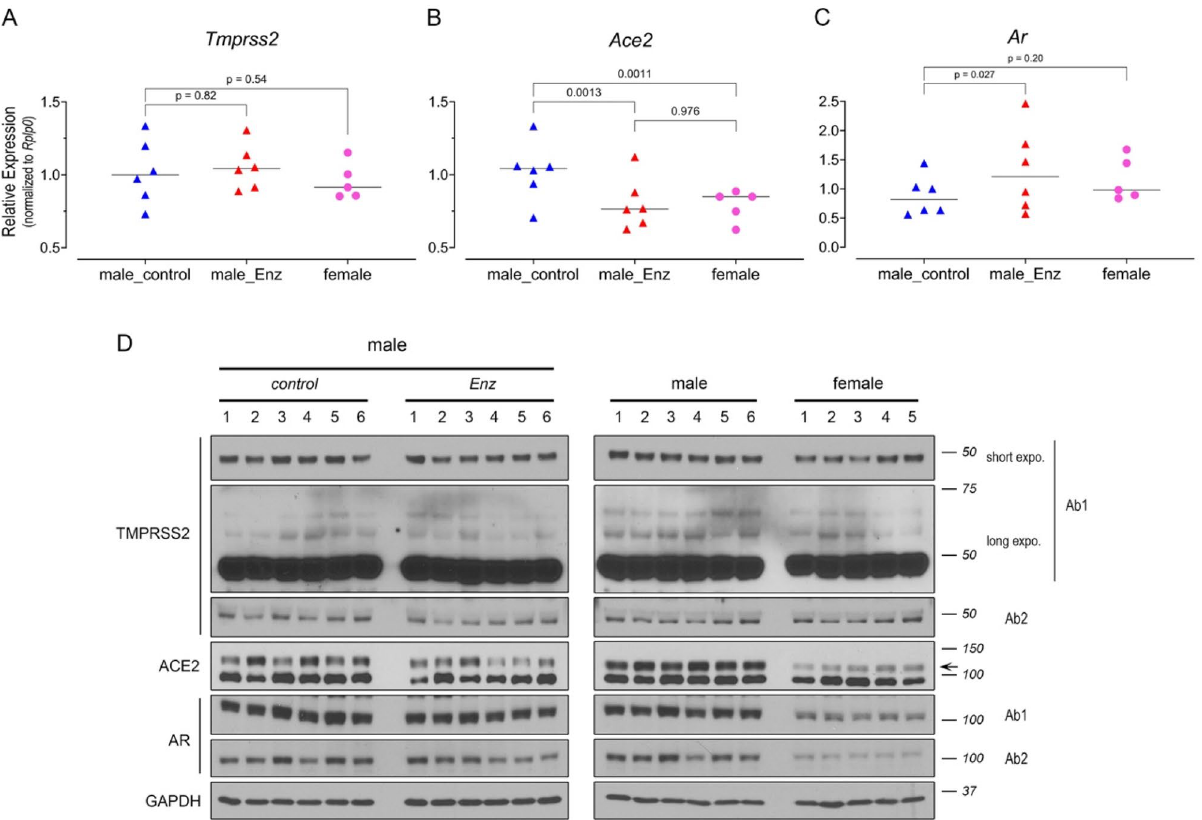
Figure 4. AR and ACE2 protein but not TMPRSS2 present a pattern of sex discordance in mouse lung. ( A – C ) Transcript levels of Tmprss2 ( A ), Ace2 , ( B ) Ar ( C ) in female (n = 5) and male NSG mice treated with control (n = 6) or Enz-formulated diet (n = 6). Gene expression was assessed in triplicate and normalized to Rplp0 levels. The statistical differences were calculated using one-way ANOVA (overall ANOVA p-values: Tmprss2 , 0.274; Ace2 , 0.0003; Ar , 0.031) with Tukey’s post hoc test as indicated in each graph. Results are shown as mean ± s.d. (n = 3 technical repeats). ( D ) Immunoblots showing the expression of pulmonary TMPRSS2, ACE2 and AR in male mice fed with Enz or control chow for 11 days, and in male vs female mice fed with regular diet. Results are representative of 4 technical repeats. TMPRSS2 (Ab1: ab92323; Ab2: 14,437–1-AP) and AR (Ab1:PG-21 and Ab2: N-20). Arrow indicates the location of ACE2 (detected by